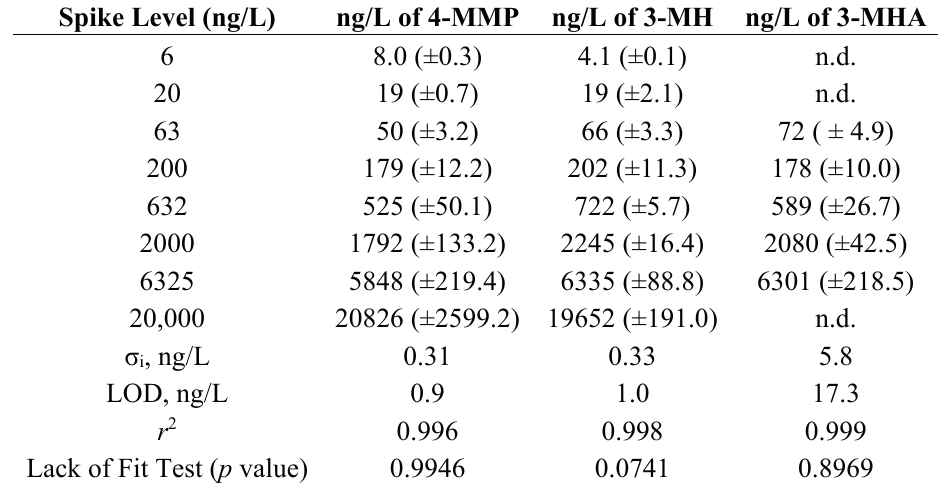
Table 1. The observed concentrations at varying levels of 4-mercapto-4-methyl-2-pentanone (4-MMP), 3-mercaptohexanol (3-MH), and 3-mercaptohexylacetate (3-MHA) resulting from standard